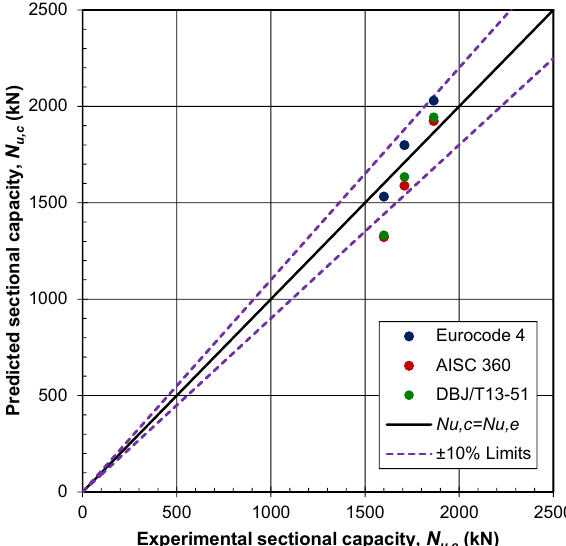
Figure 20. Comparison of the plastic sectional capacity between predicted and test results.